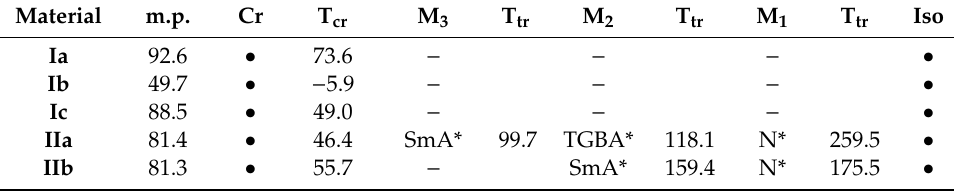
Table 1. Sequence of phases, phase transition temperatures ( ◦ C) measured on cooling (5 K min − 1 ) and melting points, m.p. ( ◦ C), measured on heating (5 K min − 1 ) determined by Di ff erential Scanning Calorimetry (DSC) for the Ia-c and IIa,b materials.